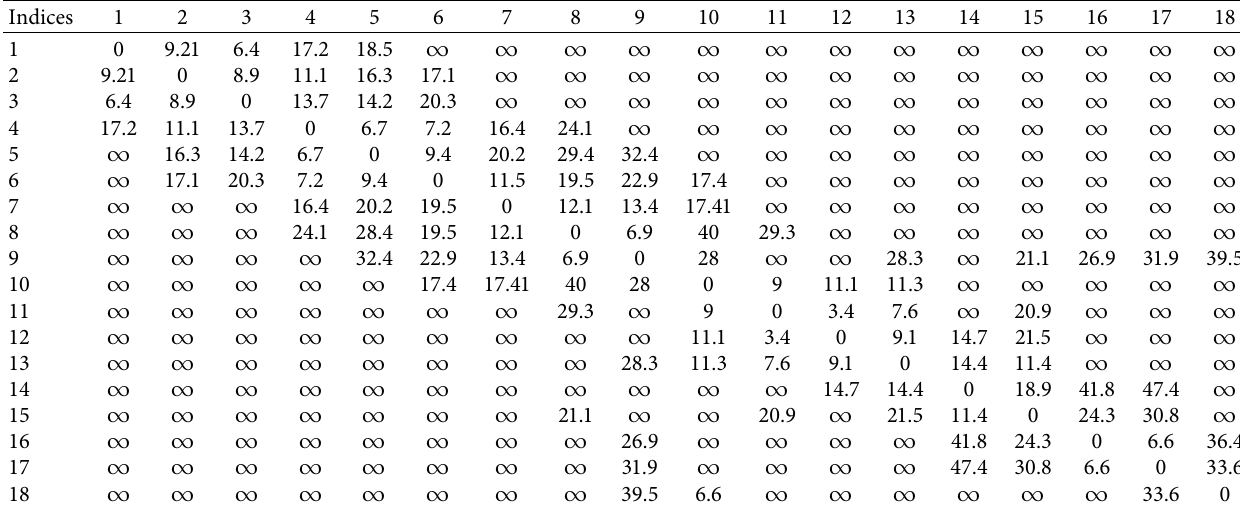
Table 2: Te distance among possible charging stations in